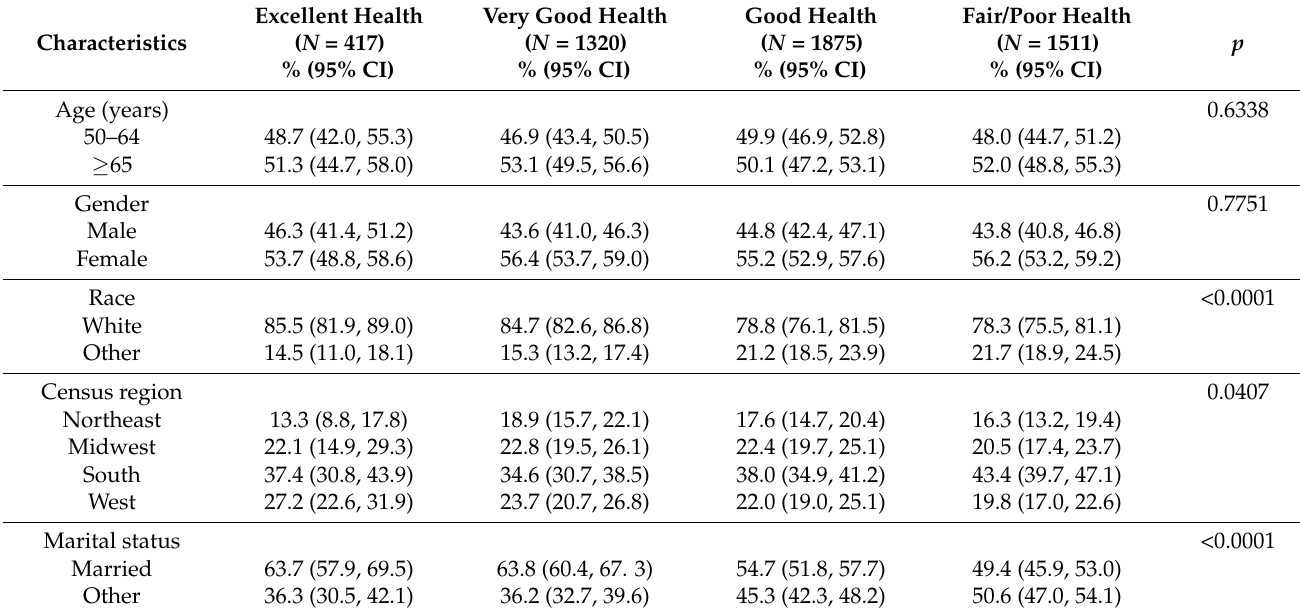
Table 1. Sample characteristics of United States older adults (age ≥ 50 years) with self-reported pain in the past four weeks, stratified by self-reported health